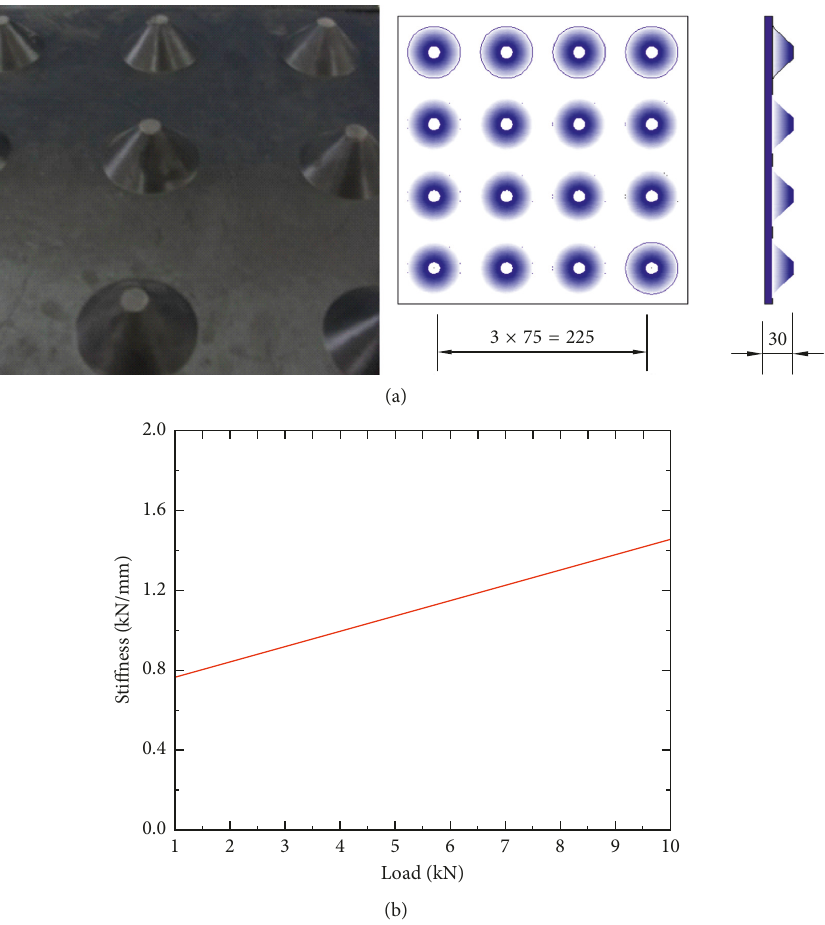
Figure 3: Rubber damping. (a) Damping pad. (b) Relationship between load and stiffness.